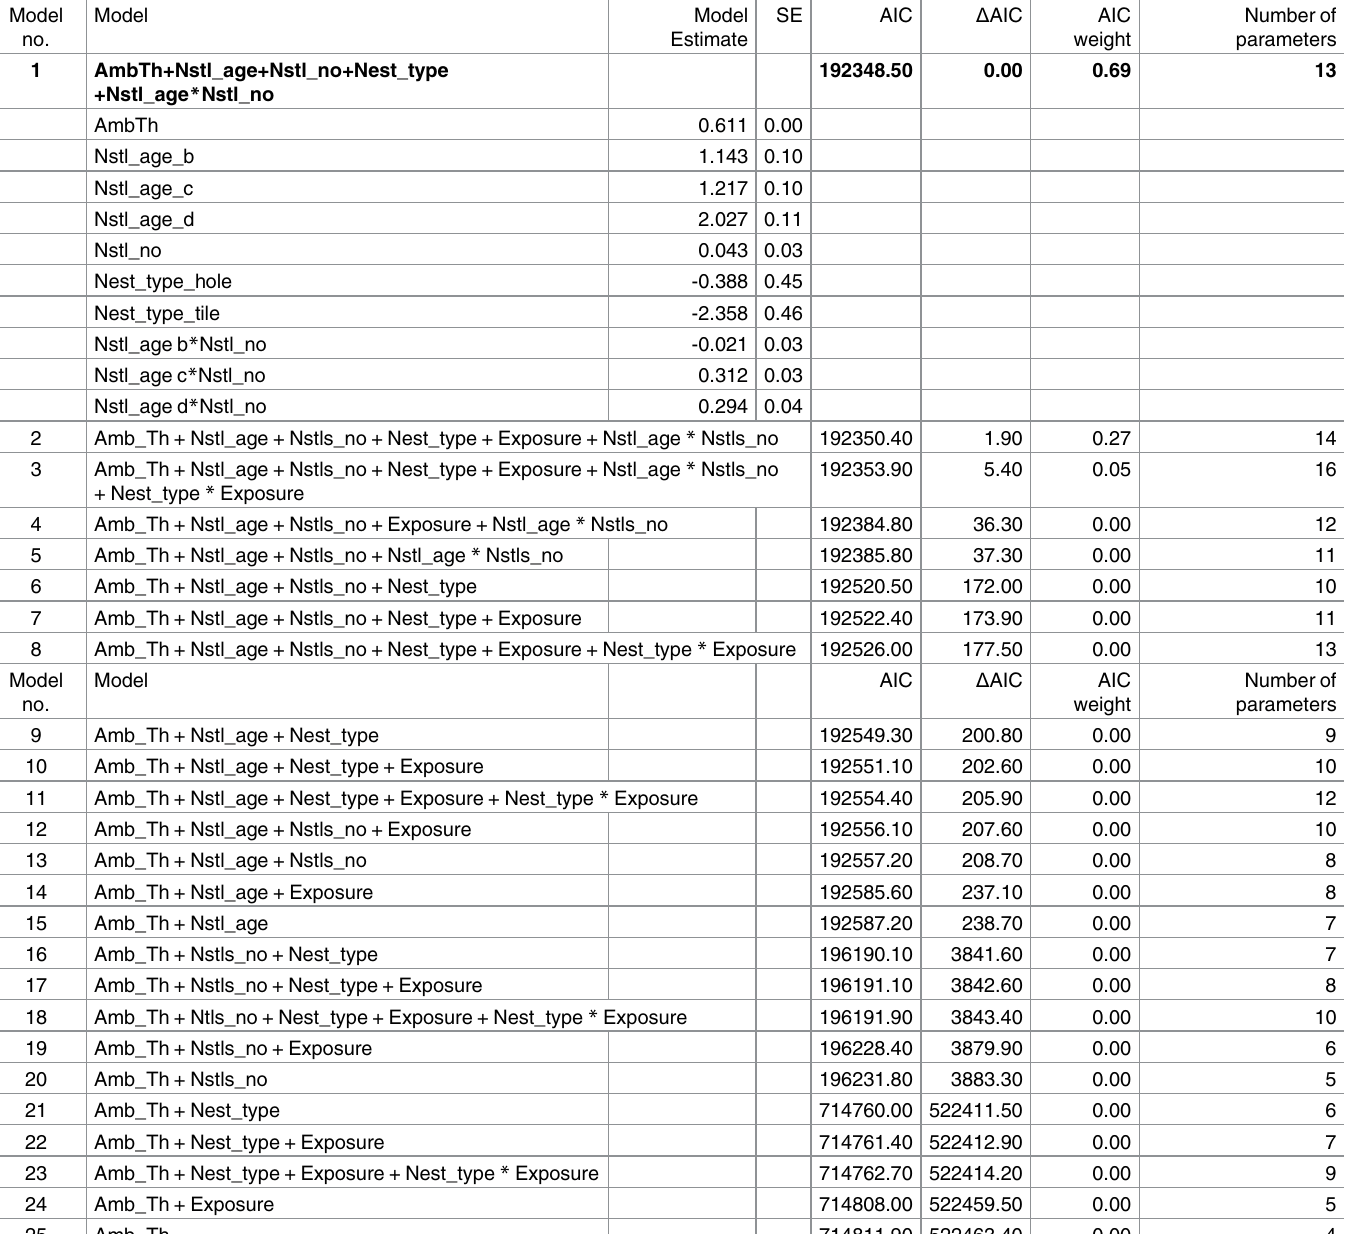
Table 1. Full set of GLMMs testing for the effectsof abiotic (weathermetrics, nest features) and biotic (chick number and age) variables on temper- atures recorded hourly inside 108 nests of lesser kestrels (191,035 temperature recordings in total). Model estimates are shown only for the best model. Model